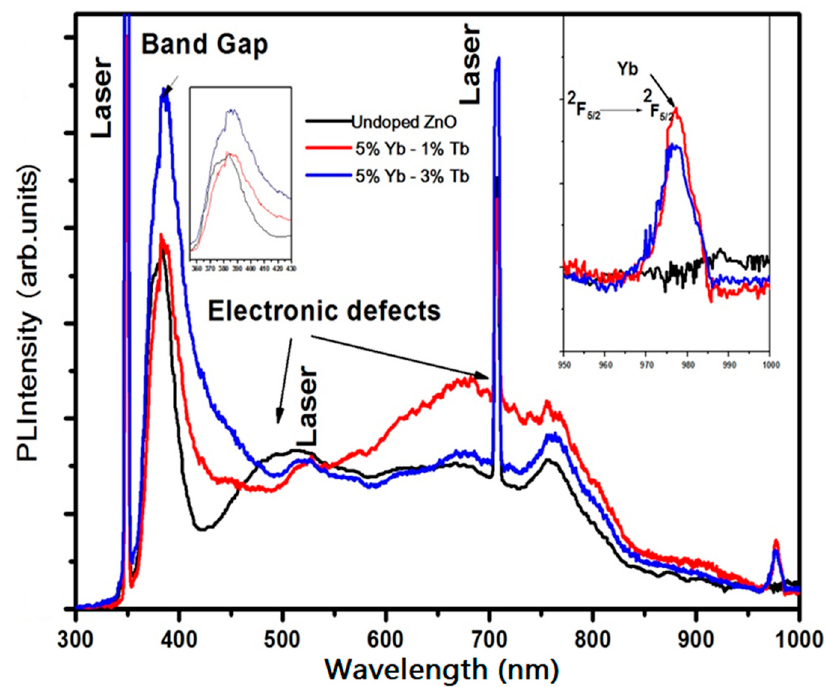
Figure 5. Photoluminescence at room temperature for undoped ZnO, ZnO: 5%Yb 3+ -1% Tb 3+ and 5%Yb 3+ -3%Tb 3+ films. The inset shows the lines transition of Yb 3+ between the levels 2 F 5/2 and 2 F 7/2 .